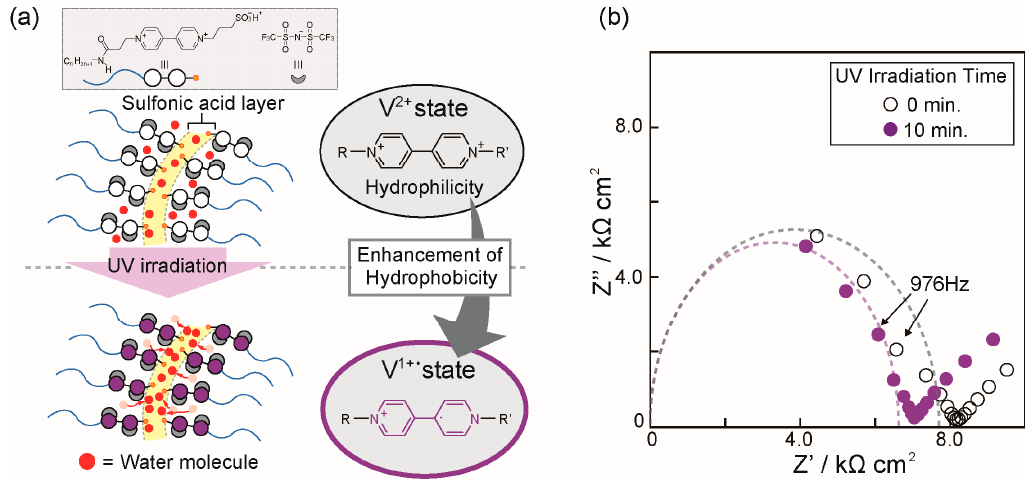
Figure 5. ( a ) An illustration of a concept for photo-responsive switchable proton conduction materials; ( b ) Cole-cole plots of the V 2+ ZI-12/HTf 2 N mixture before and after 10 min of UV irradiation.